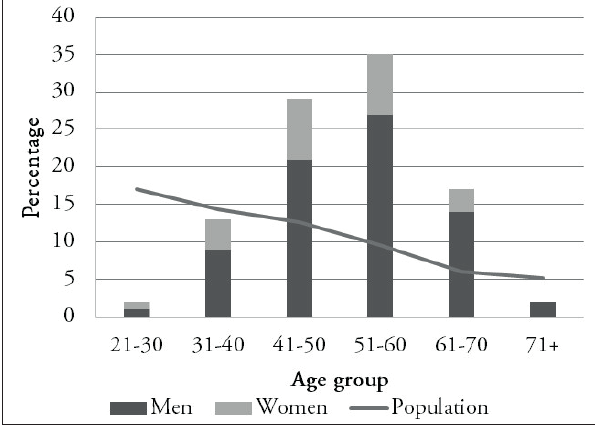
Figure 3: Global means by age and gender, upper and lower chamber, compared with population